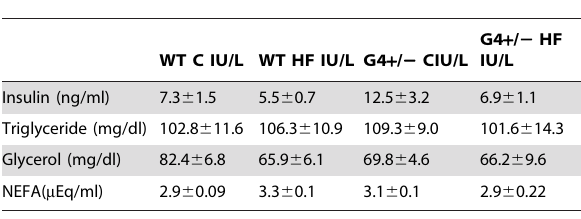
Table 1. Metabolic phenotype of 6 week old male